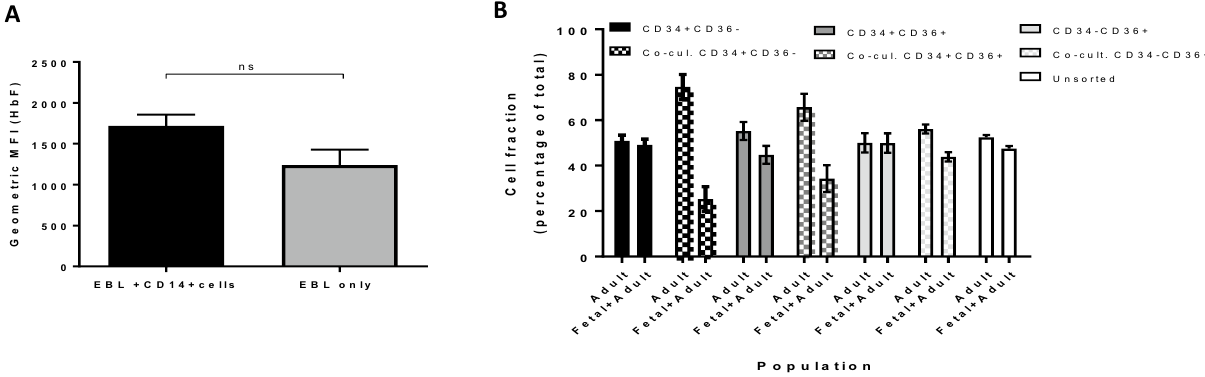
Figure 4. Inhibition of HbF expression by CD14+ cells occurs early during hematopoiesis/erythropoiesis. ( A ) Erythroblasts (CD71+/CD235low) were cultured with and without PBMC-isolated CD14+ cells as indicated in material and methods. Bar graph shows the mean fluorescent intensity of gamma globin expression as measured by flow cytometry. ( B ) Hematopoietic progenitors were sorted based on their expression of CD34 and CD36 expression. In short, CD34+CD36− represent hematopoietic stem and progenitors cells, CD34+CD36+ cells are committed to a megakaryoid/erythroid fate but no myeloid fate and CD34−CD36+ cells are pro-erythroblasts 15 . Cells were cultured in presence (solid bars) or absence of PBMC-isolated CD14+ cells (striped bars). The percentage of HbA and HbA/HbF cells was measured by flow cytometry and indicated on the y-axis. Note that the reduction of HbF/HbA populations by CD14+ cells is proportional to the immaturity of the progenitors (N = 3).